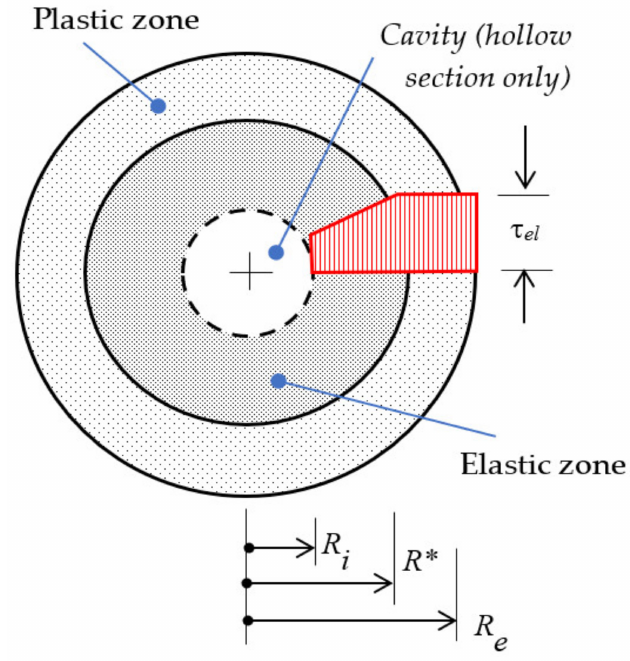
Figure 4. Elastic-plastic model of the section under